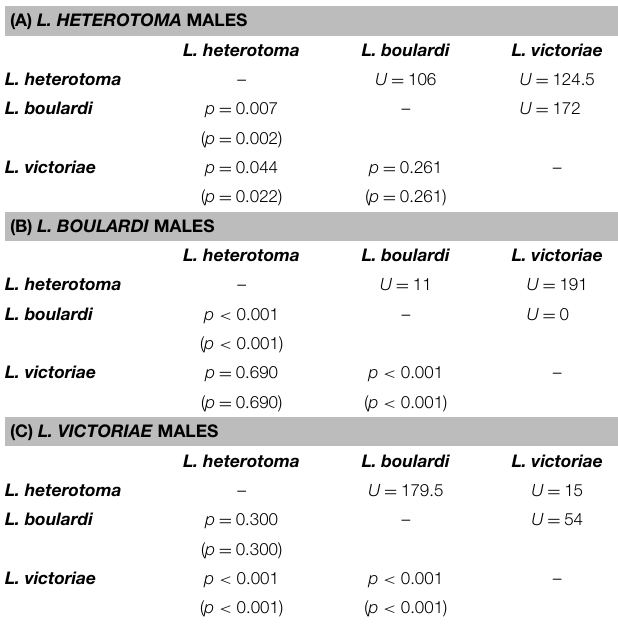
TABLE 1 | Statistical details for the pairwise comparisons of courtship duration displayed by (A) L. heterotoma , (B) L. boulardi , and (C) L. victoriae males toward conspecific and heterospecific